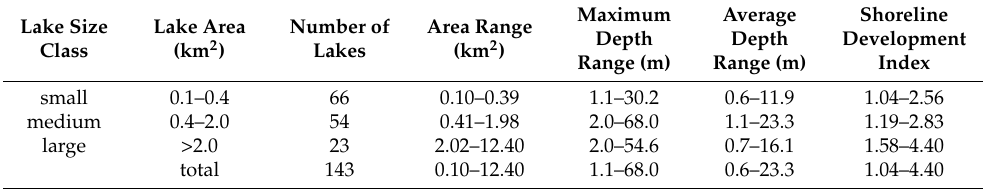
Table 1. Basic characteristics of the studied lakes in the Olsztyn Lakeland